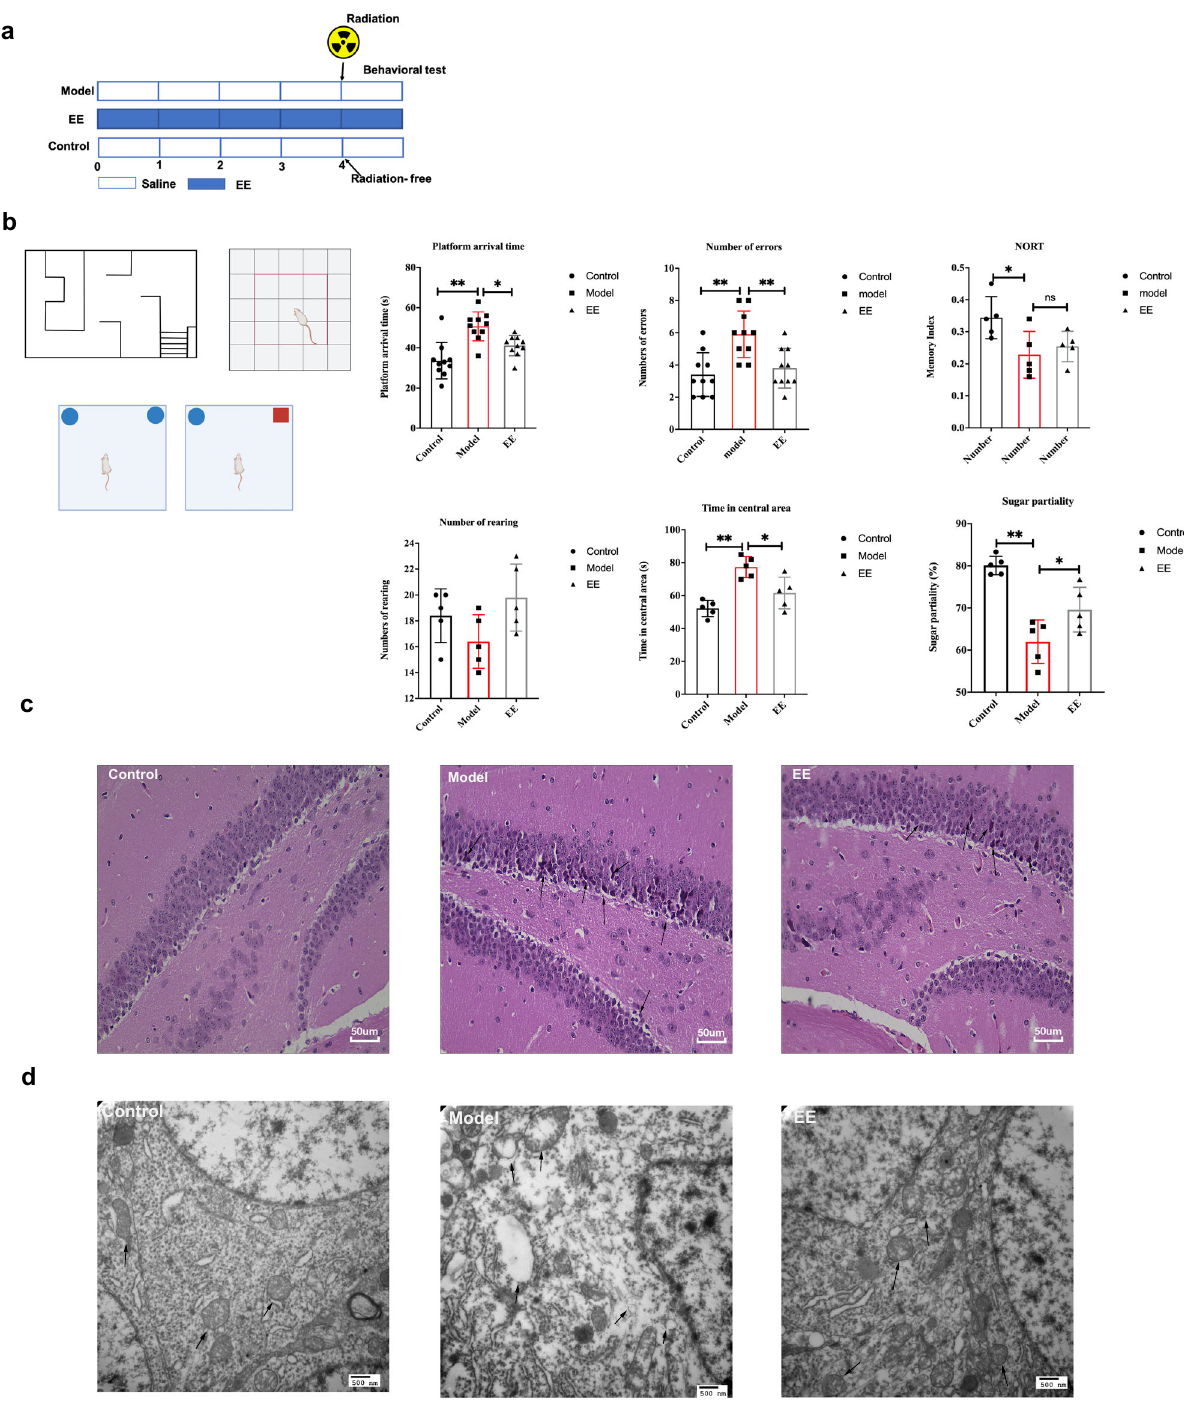
Fig. 1 EE supplementation ameliorated radiation-induced cognitive impairment and damage of neuron in hippocampus. a Design of the experiment. b Behavioral performance of the mice ( n = 5 per group, * p < 0.05, ** p < 0.01). c Histopathological analyses of hippocampus (H&E, scale bar = 50 μ m). d The ultrastructural features in hippocampus (TEM, scale bar = 500 nm.). Values are expressed as the mean ± SD ( n = 5). Statistical analyses were conducted using the one-way ANOVA followed by Tukey ’ s post hoc test, * p < 0.05, ** p <